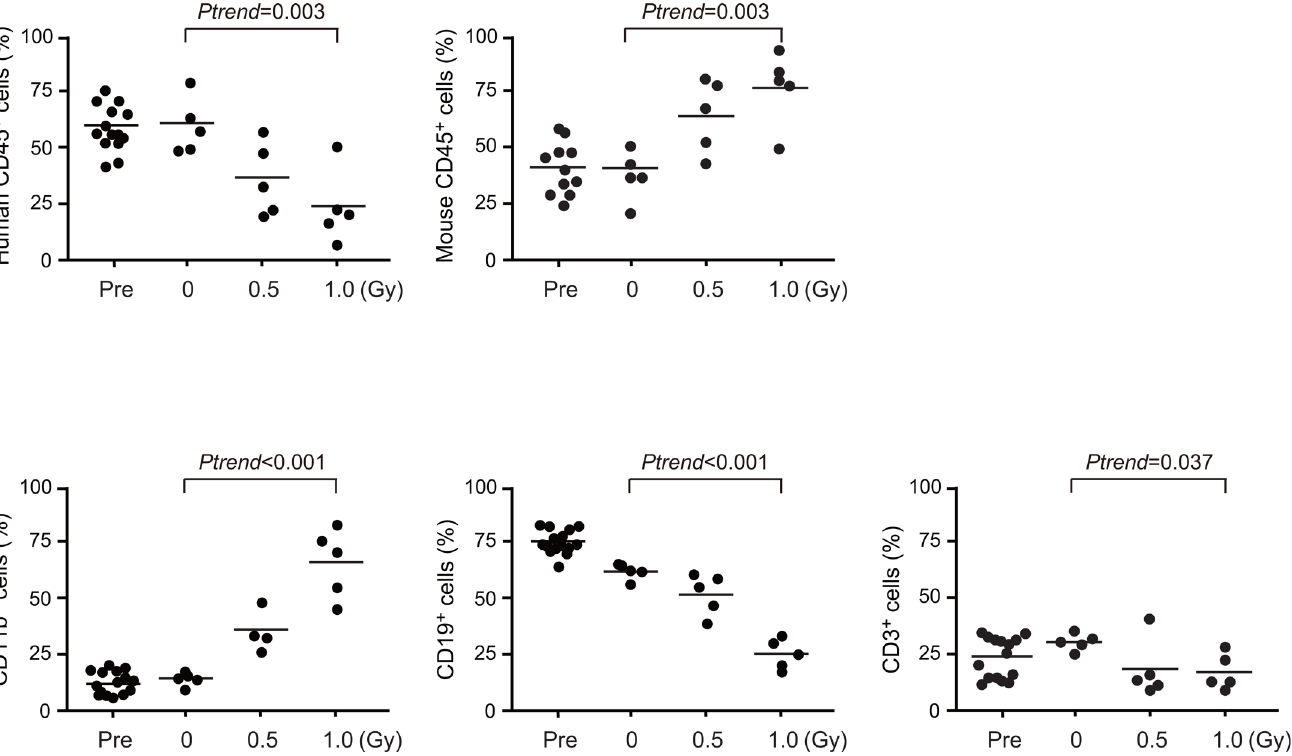
Fig 4. Long-term radiation effects on human HSPCs in primary recipient mice. Changes in chimerism of human hematopoietic cells in the PB of primary recipients at 12 weeks post-irradiation. Chimerism of CD45 + human and mouse hematopoietic cells in the PB are shown in upper panels. The percentages of CD11b + myeloid cells, CD19 + B cells, and CD3 + T cells in CD45 + human hematopoietic cells in the PB are shown in lower panels. PB data of NOG mice just before the irradiation (Pre) are also indicated. Data are presented as scattering diagrams with medium values (bars) (Pre, n = 15; 0 Gy, n = 5; 0.5 Gy, n = 5; 1.0 Gy, n = 5). P -values for trend were calculated by nonparametric Jonckheere-Terpstra test. The t-test was used for comparison of mean